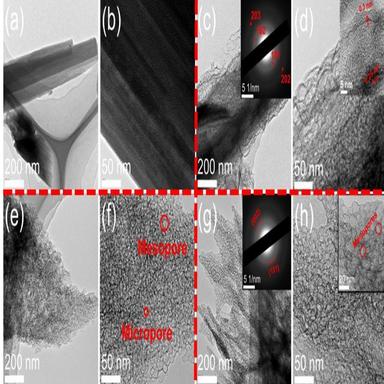
HR-TEM images at different magnifications of (a,b) Zn-TFBDC, (c,d) ZnO/PC, (e,f) PC, and (g,h) APC samples (the insert image is SAED pattern of corresponding sample).